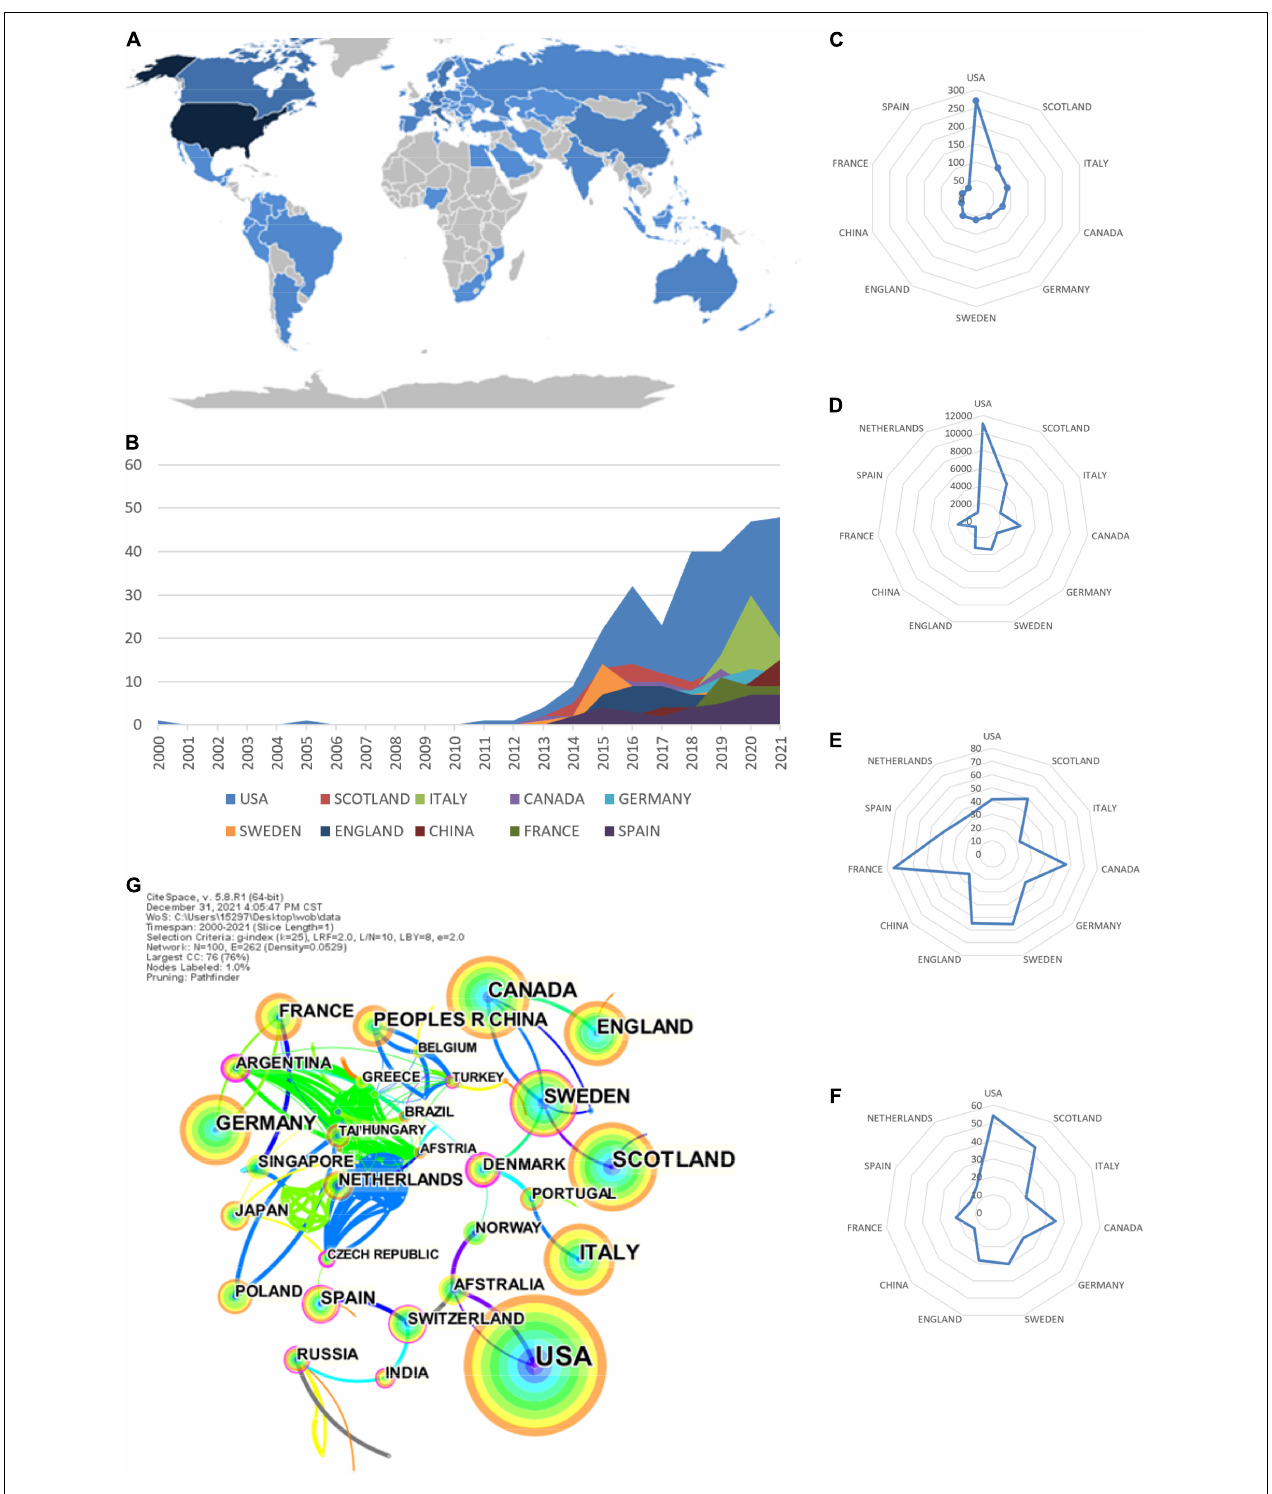
FIGURE 2 | Leading countries for ARNI application research in the cardiovascular system. (A) Geographical distribution of global output; (B) Annual output trend of the top 10 productive countries; (C) Radar map of the top 11 productive countries; (D) Radar map of TGCS of the top 11 productive countries; (E) Radar map of average cited of the top 11 productive countries; (F) Radar map of h-index for the top 11 producing countries; (G) CiteSpace visualization of the countries participating in the ARNI in Cardiovascular Systems Study. Notes: The size of node reflects the co-occurrence frequencies, and the links indicate the co-occurrence relationships. The color of node and line represents different years, and node with purple round means high betweenness centrality ( > 0.1).